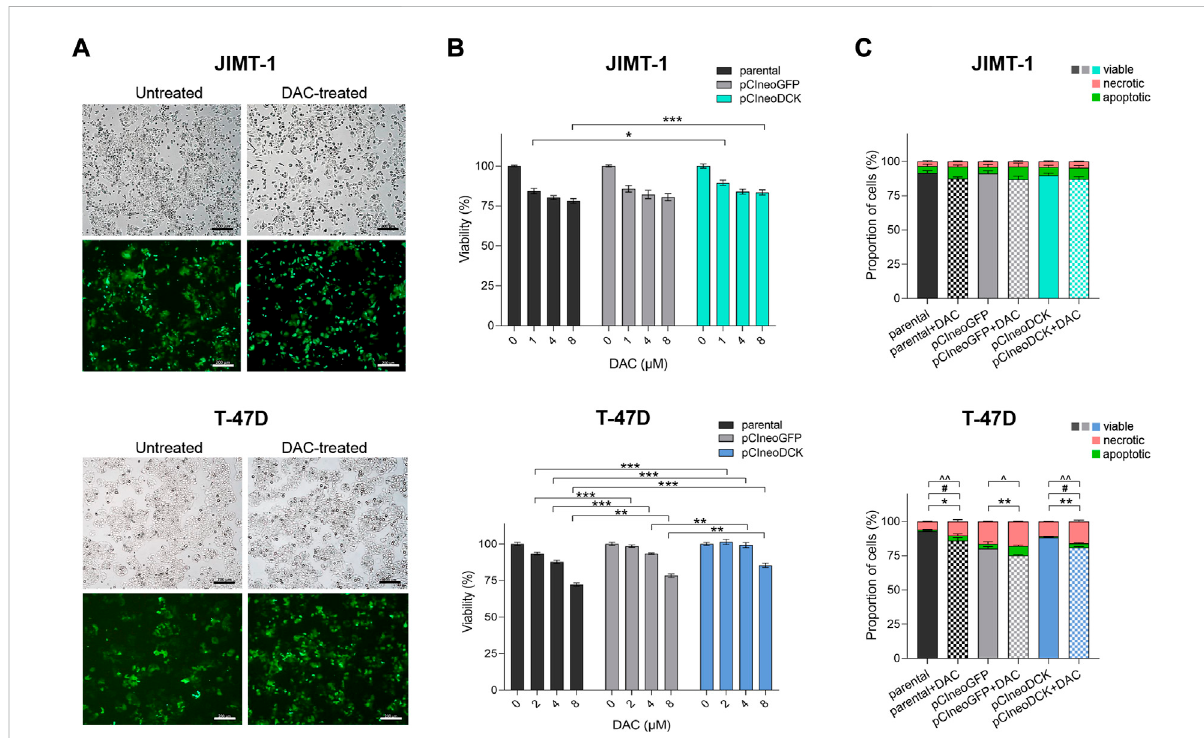
FIGURE 2 Effect of cell transfection on cell survival and response to decitabine (DAC). (A) The morphology and evaluation of transfection ef fi ciency in JIMT-1 and T-47D cell lines transfected with GFP expression vector pCIneoGFP (mock plasmid). Representative images of untreated and DAC- treated pCIneoGFP cells were taken on a light microscope Axio Vert. A1 ZEISS, magni fi cation 5 x; (B) Cell viability assessment of parental and transfected JIMT-1and T-47D cells after DAC treatment, added every 24 h for a total of 72 h. Relative cell viability values were evaluated by luminescentviabilityassayandexpressedasmean±SEM; (C) Flowcytometrymeasurementoftheapoptosisandnecrosisinparentalandtransfected JIMT-1 and T-47D cells. Statistically signi fi cant difference from negative control according to one-way ANOVA (Bonferroni ’ s or Tamhane ’ s multiple comparisons test), * p < 0.05, ** p < 0.01, *** p < 0.001 or Kruskal-Wallis test; ^ viable, #apoptotic, *necrotic